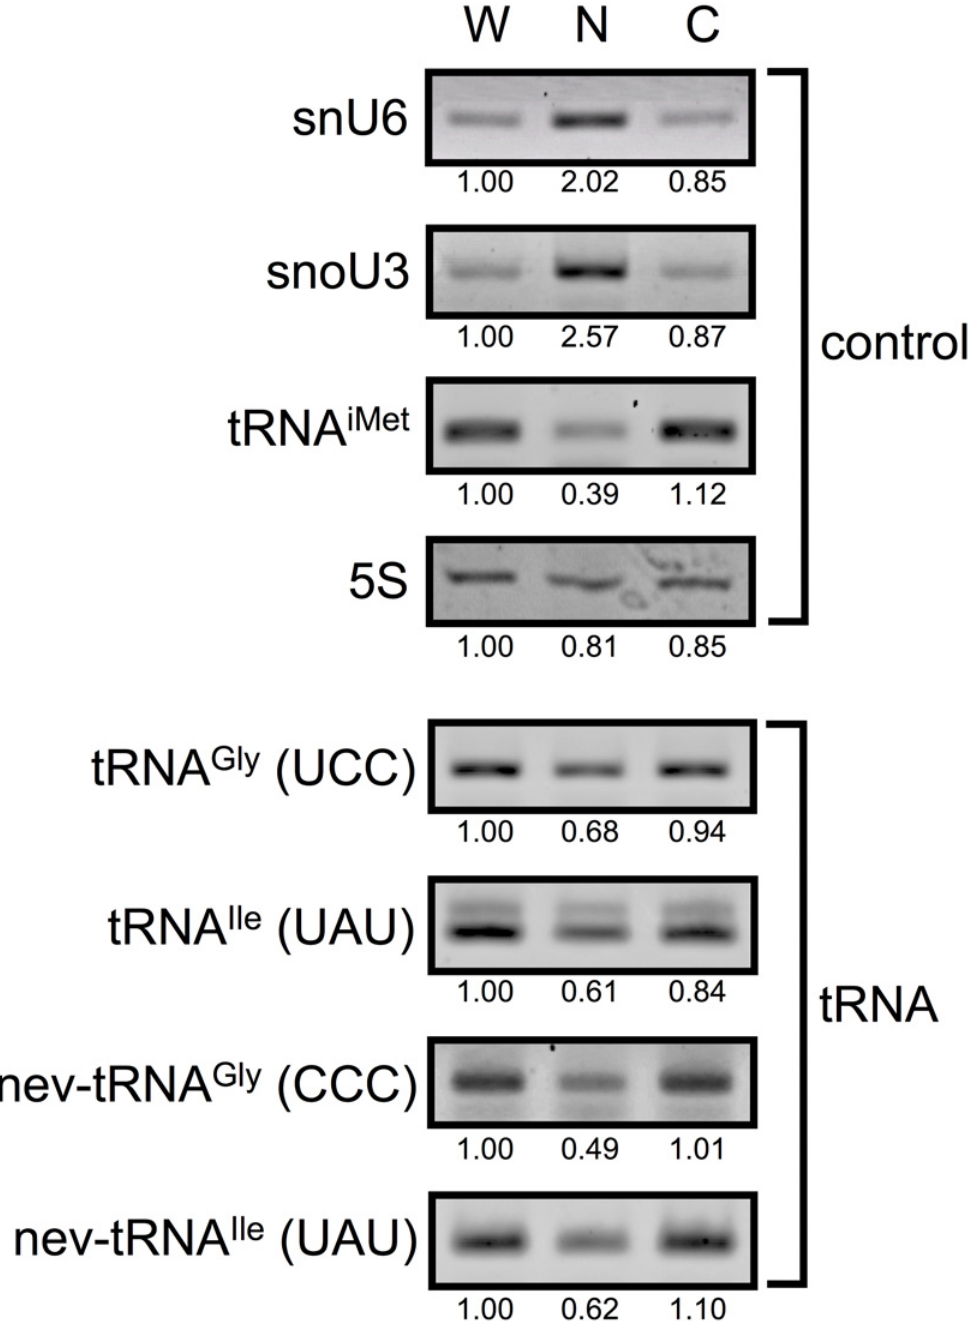
Figure 2. Subcellular localization of nev-tRNAs in C. elegans . RNA was isolated from each fraction of C. elegans : whole cell (W), nuclear (N), or cytoplasmic (C). RT – PCR analysis was used to detect snU6 and snoU3 RNAs (nuclear markers), tRNA iMet (cytoplasmic marker), and four tRNAs (nev- tRNA Gly and nev-tRNA Ile , and their cognate tRNAs). 5S rRNA expression is shown as the loading control. Band densities were evaluated semiquantitatively with densitometry.